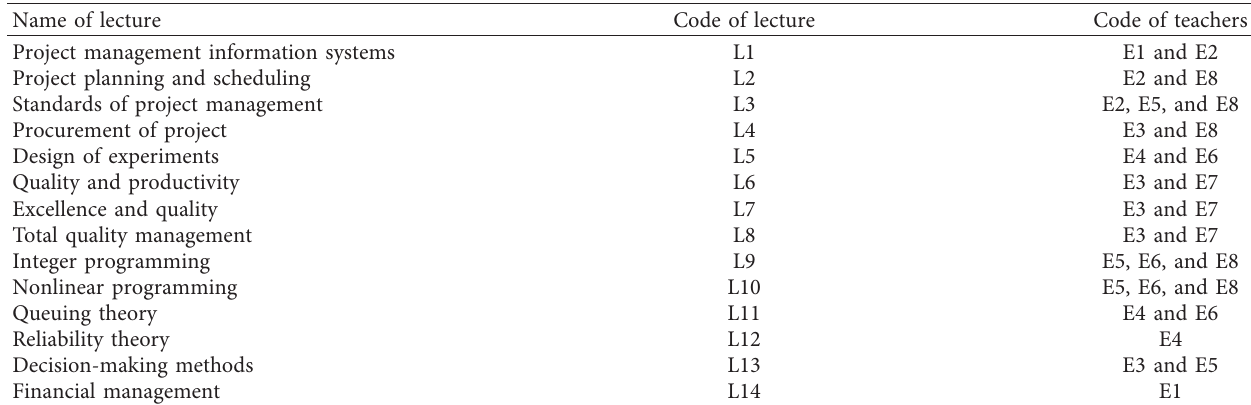
Table 10: Available postgraduate